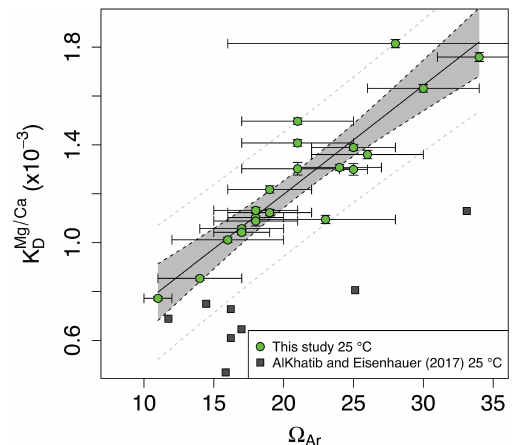
Figure 4. Sensitivity of K Mg / Ca to (cid:127) Ar at 25 ◦ C. Horizontal error D bars represent 1 standard deviation of (cid:127) Ar while aragonite precipi- tated in each experiment. Grey shading represents the standard error of the curve, and the dashed grey lines represent the standard error of prediction. The grey squares show the AlKhatib and Eisenhauer (2017) data replotted against (cid:127) Ar (see their Fig. 4 for a plot against precipitation